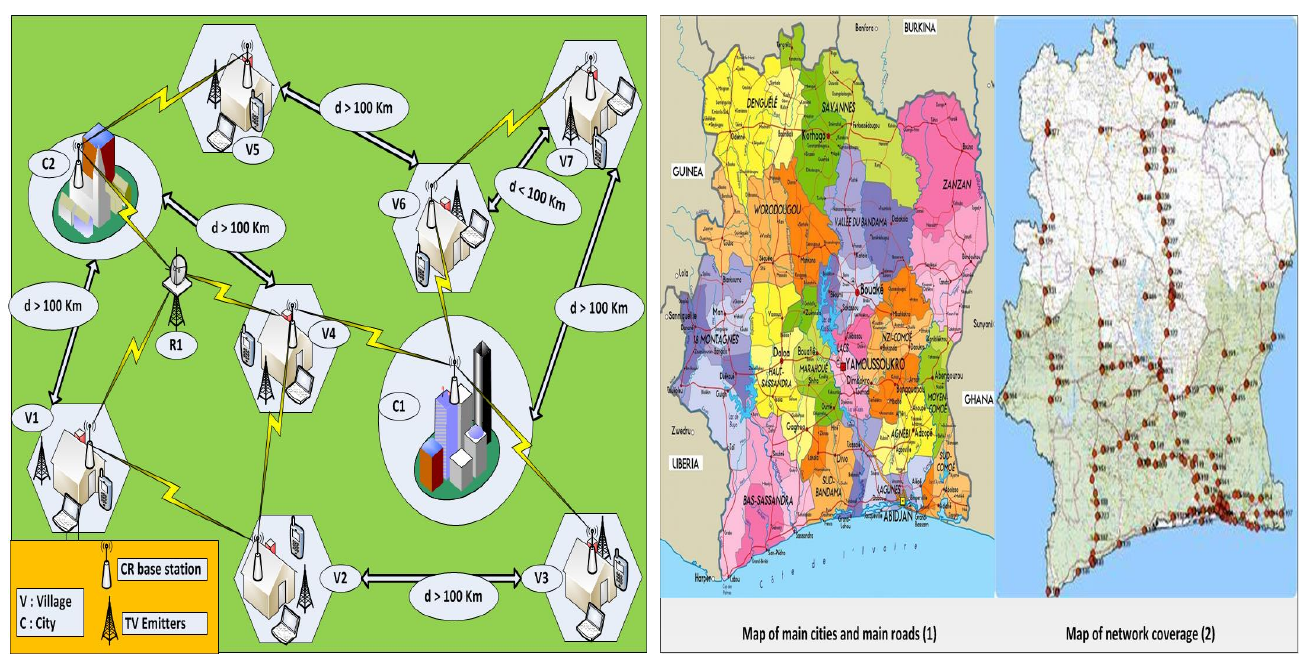
Figure 3. Planned Cognitive Radio Networks Figure 4. Network coverage map in Côte d’Ivoire